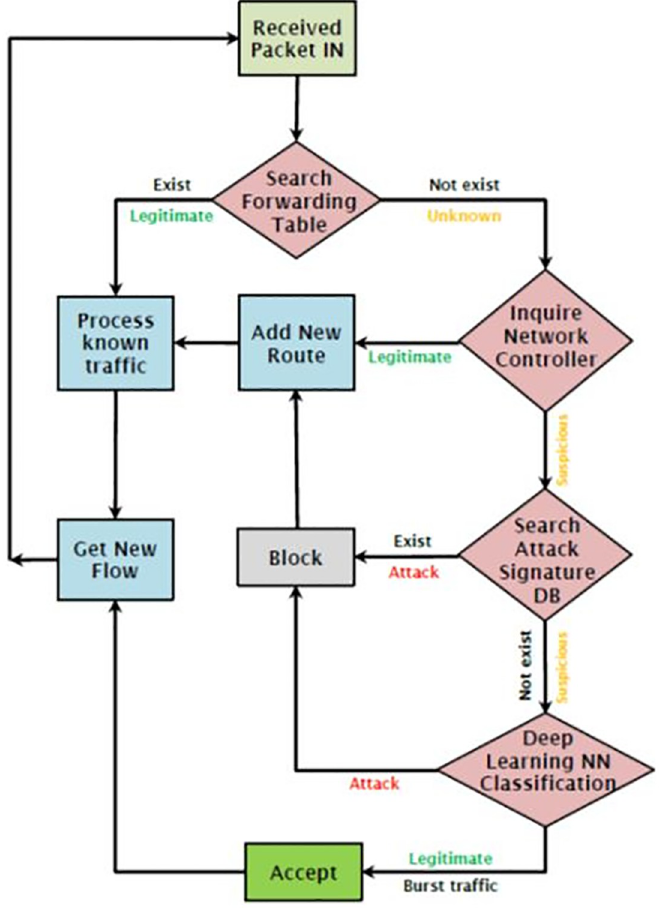
Fig 5. Received packet flow